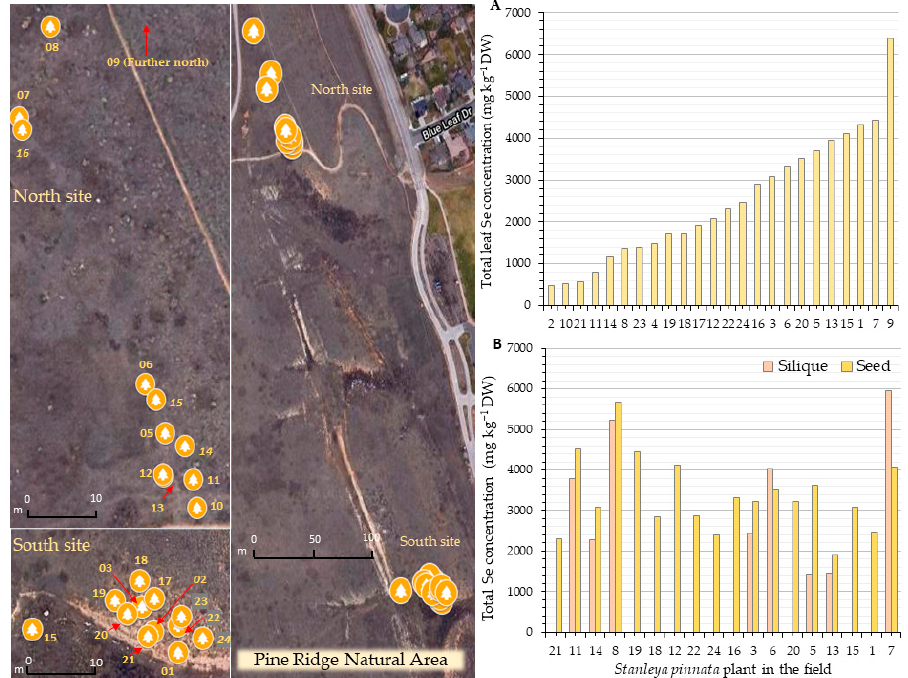
Figure 3. Stanleya pinnata plant locations at the Pine Ridge natural area (left) and tissue Se concen- trations (right). The numbers on the horizontal axis represent the collection number for each plant. ( A ) Leaf Se concentration ordered according to their Se levels. ( B ) Silique and seed Se concentration for the same plants; the numbering was maintained for consistency. The Se variation was more pronounced in the siliques when compared to the seeds in all plants analyzed from both sites. Only 4-fold (Figure 2B) and 3-fold (Figure 3B) seed Se variations were found, respectively, among Coyote Ridge and Pine Ridge plants. A greater Se variation, 130-fold, was found in the siliques from plants sampled in Coyote Ridge (Figure 2B), and a 4-fold variation was determined in the Pine Ridge group (Figure 3B). The large silique Se variation in Coyote Ridge reflected the relatively low Se levels found in a few sampled plants; indeed, 17% of all plants from that site showed Se levels below 750 mg kg − 1 DW. All the seeds and most of the siliques analyzed contained Se concentrations typical of Se hyperaccumulators for both studied sites. On average, the plants collected from Coy- ote Ridge accumulated 4043 mg kg − 1 DW and 2267 mg kg − 1 DW in seeds and siliques, re- spectively. The Pine Ridge plants contained on average 3372 mg kg − 1 DW in seeds and 3323 mg kg − 1 DW in the siliques. It should be noted that the seed Se concentration was consistently high for all plants analyzed, even when the silique Se level was low in the same plant. On average, the Se concentration was higher in the reproductive organs than the leaf tissues for the Coyote Ridge plants. A 3-fold higher Se concentration in the siliques and 5-